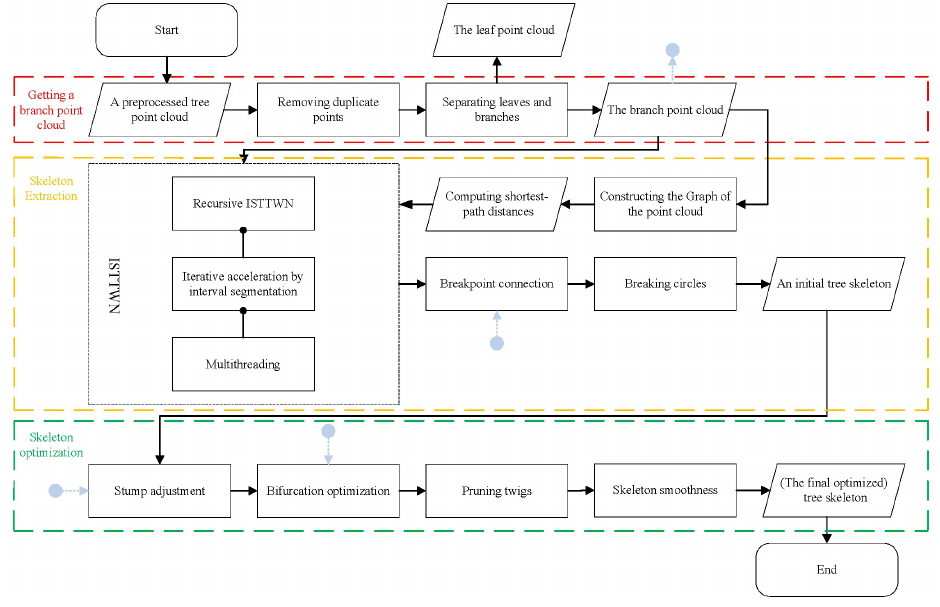
Figure 1. The overall